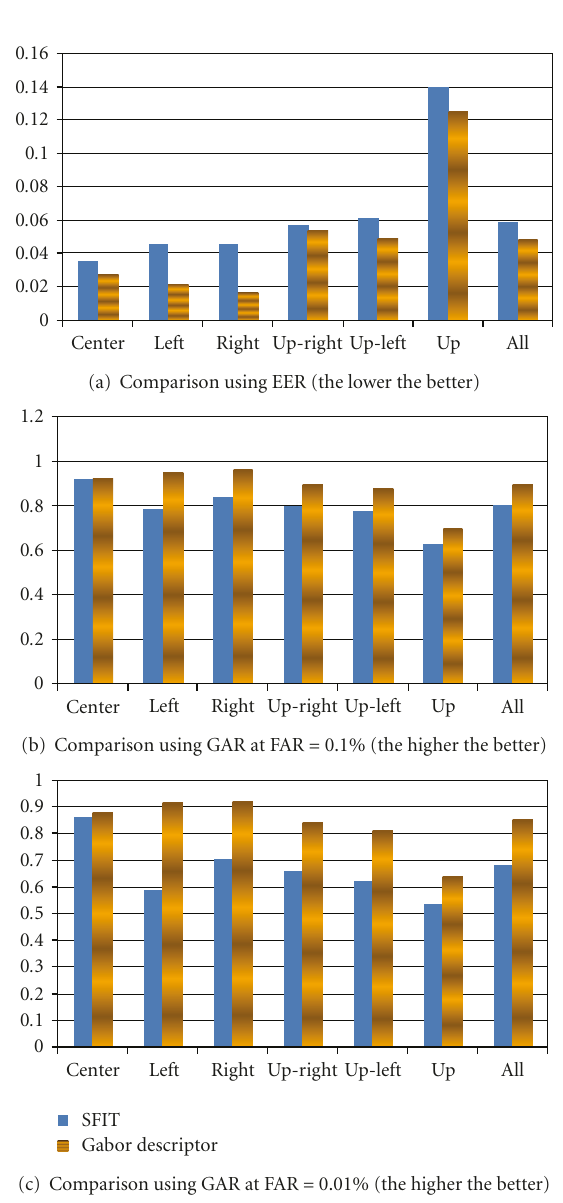
Figure 12: Comparisons between the regional SIFT method and the proposed Gabor Descriptor method using EER, GAR at FAR = 0.1%, and GAR at FAR =